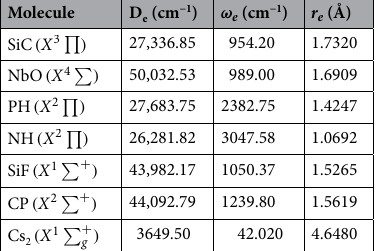
Table 1. Spectroscopic constants used for the study 39,40 .